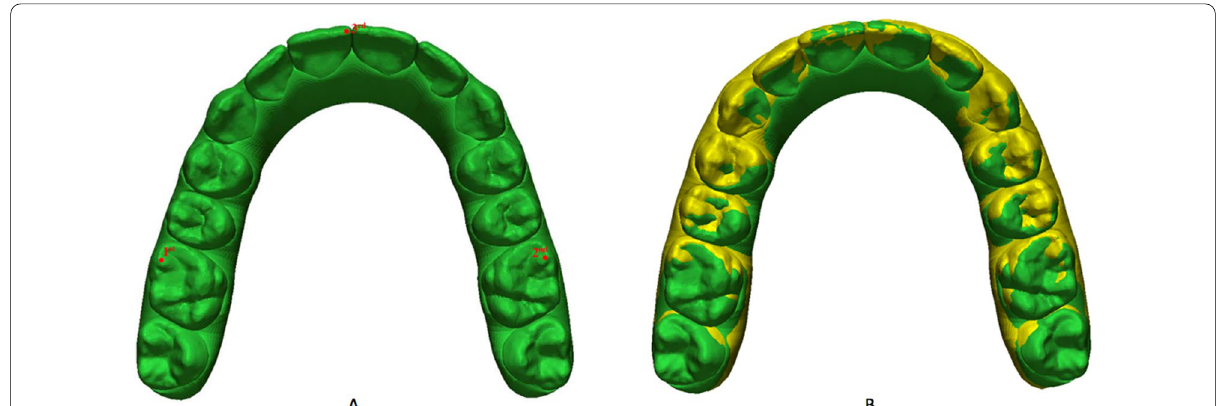
Fig. 1 A Overlay performed by the landmark-based method; B Overlay performed by the surface-based method (best-fit alignment) using a best-fit